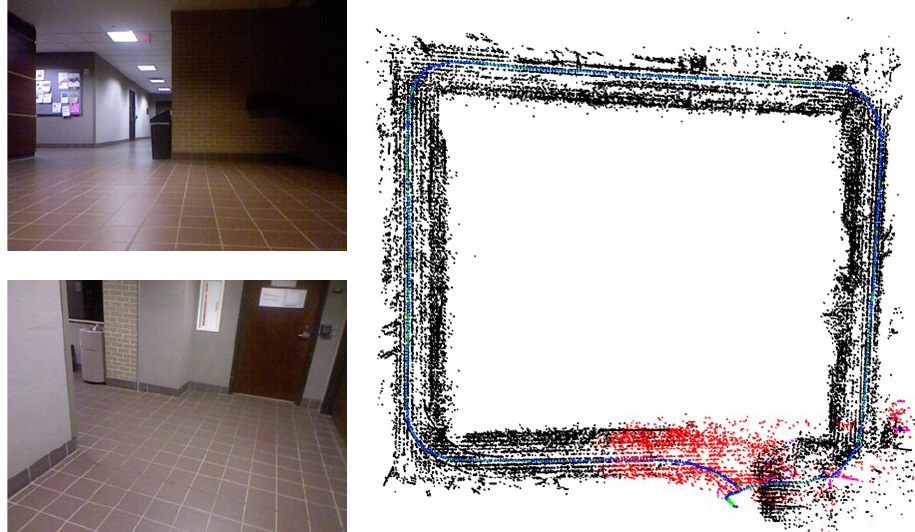
Figure 12. Drift for TAMU-RGB-D Corridor-A sequence.